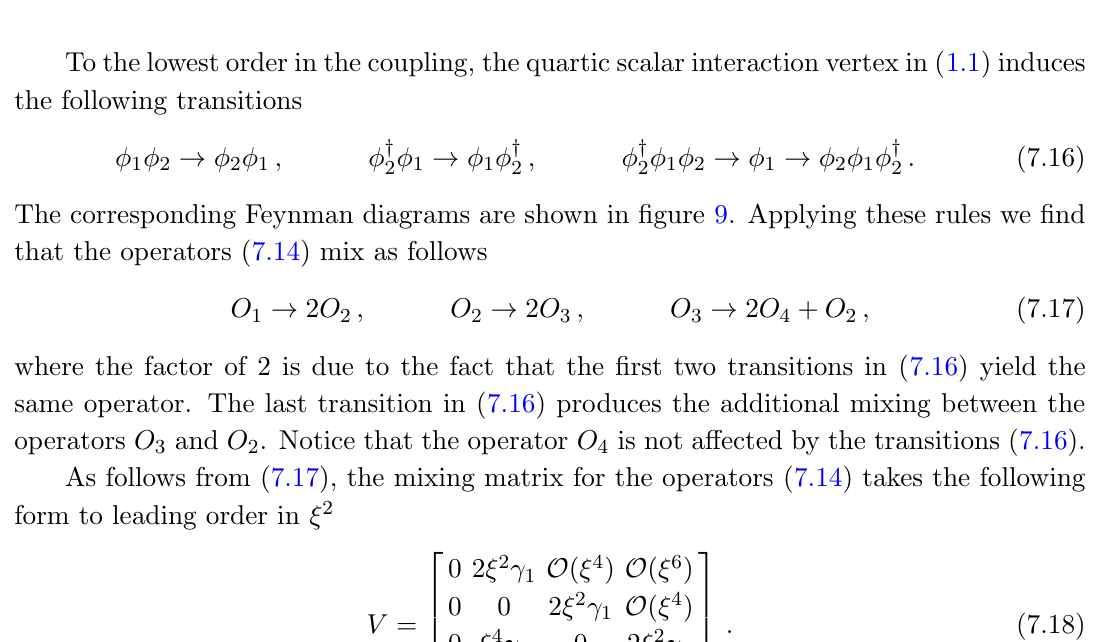
(cid:30) 1 (cid:30) 2 (cid:30) 2 ) with the operators O 4 and O 2 to the lowest order in the 1 2 depending on the direction of the 2